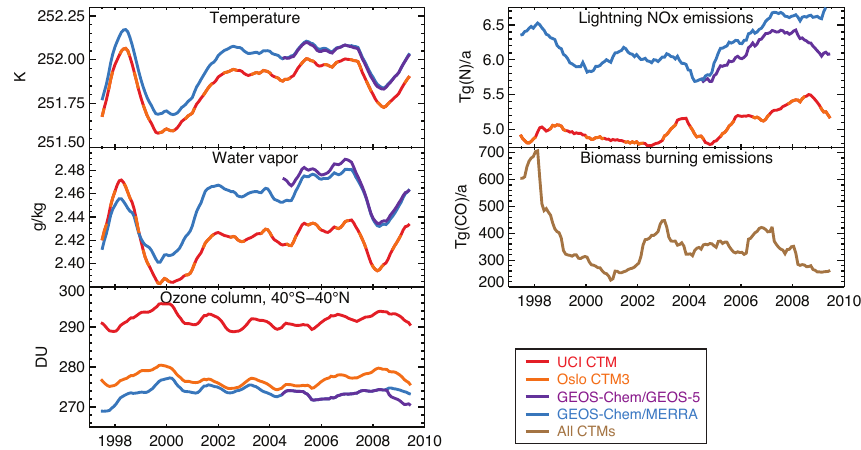
Fig. 3. Climate and emission variables controlling the interannual variation of τ CH variables are global averages, except ozone columns, which are averaged over 40 ◦ S–40 ◦ N. Colors show which inputs are used by each CTM.